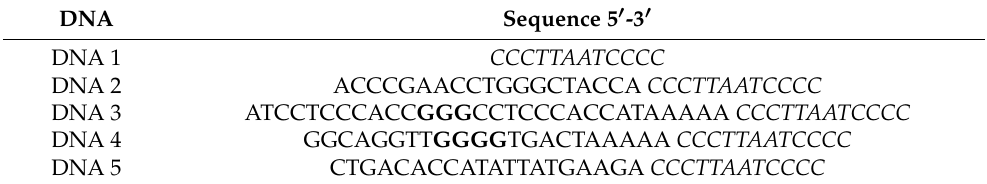
Table 1. Sequences of five single-stranded DNA.